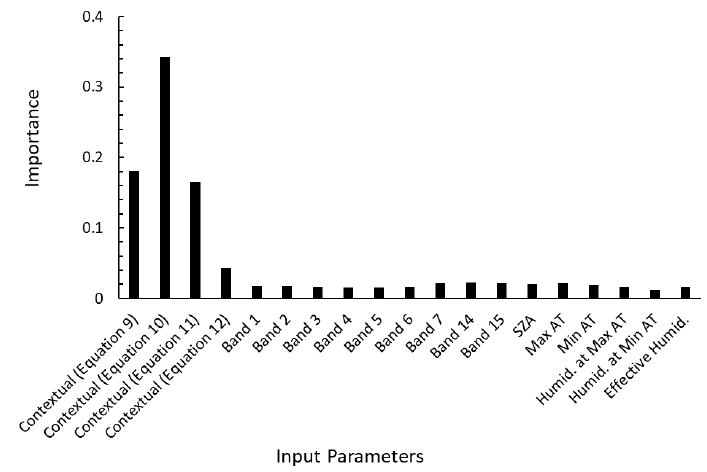
Figure 3. Importance of each parameter given to the random forest classifier in the proposed method.